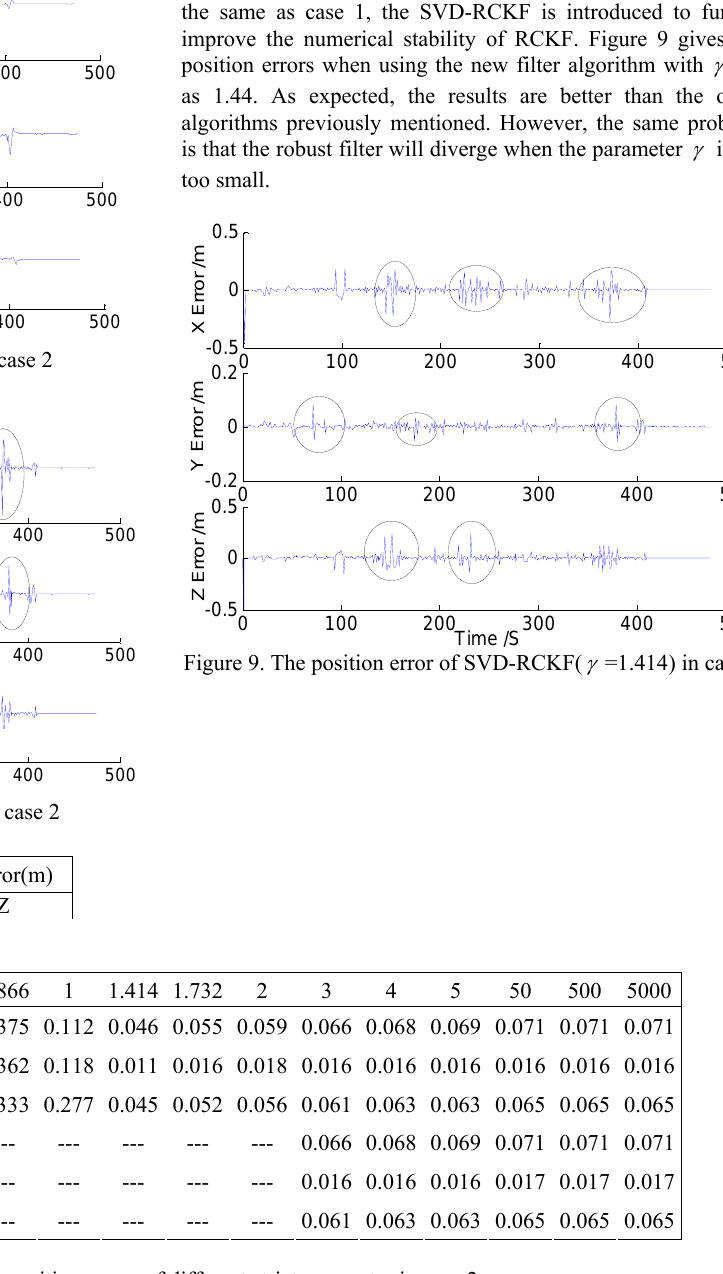
Table 5. The position errors of different strict parameter in case